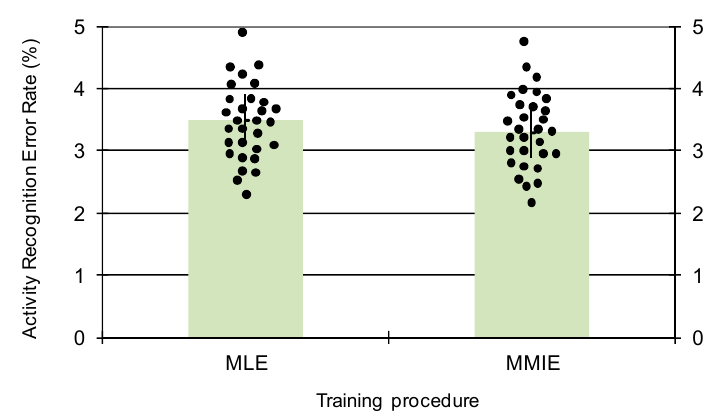
Figure 5. Activity recognition error rate depending on the training procedure including data points for all the subjects using the representation method proposed in [34].